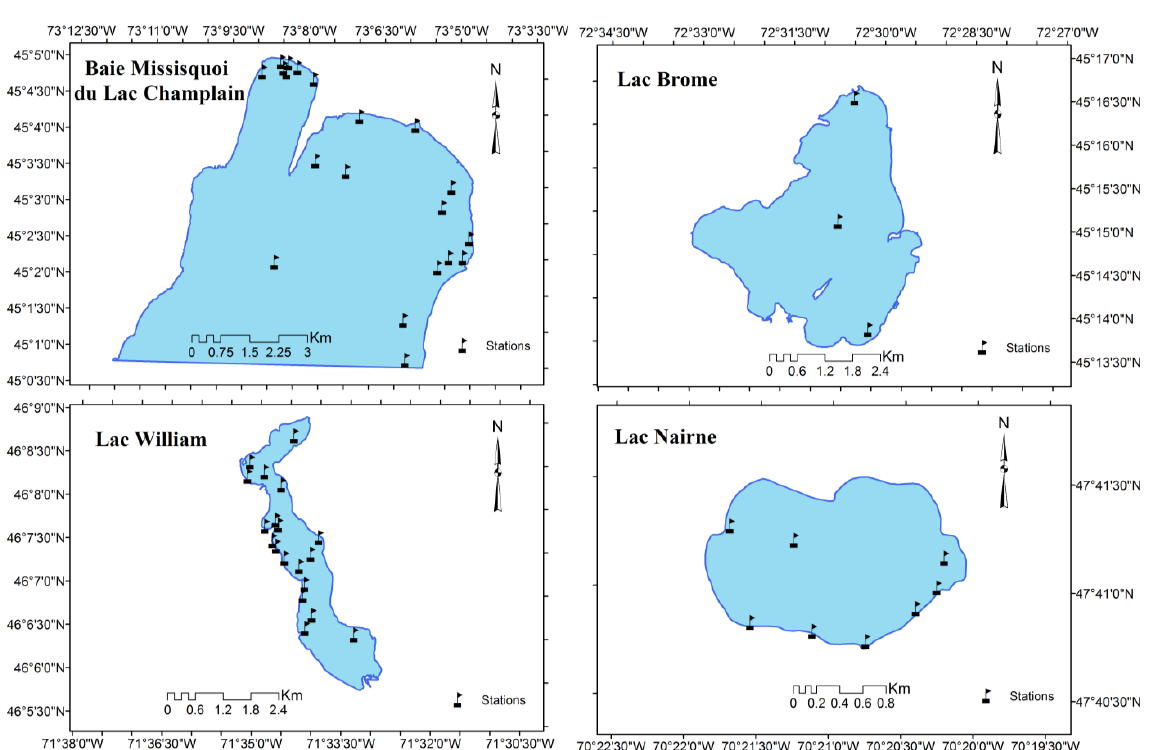
Figure 2. Water sampling stations on the four studied